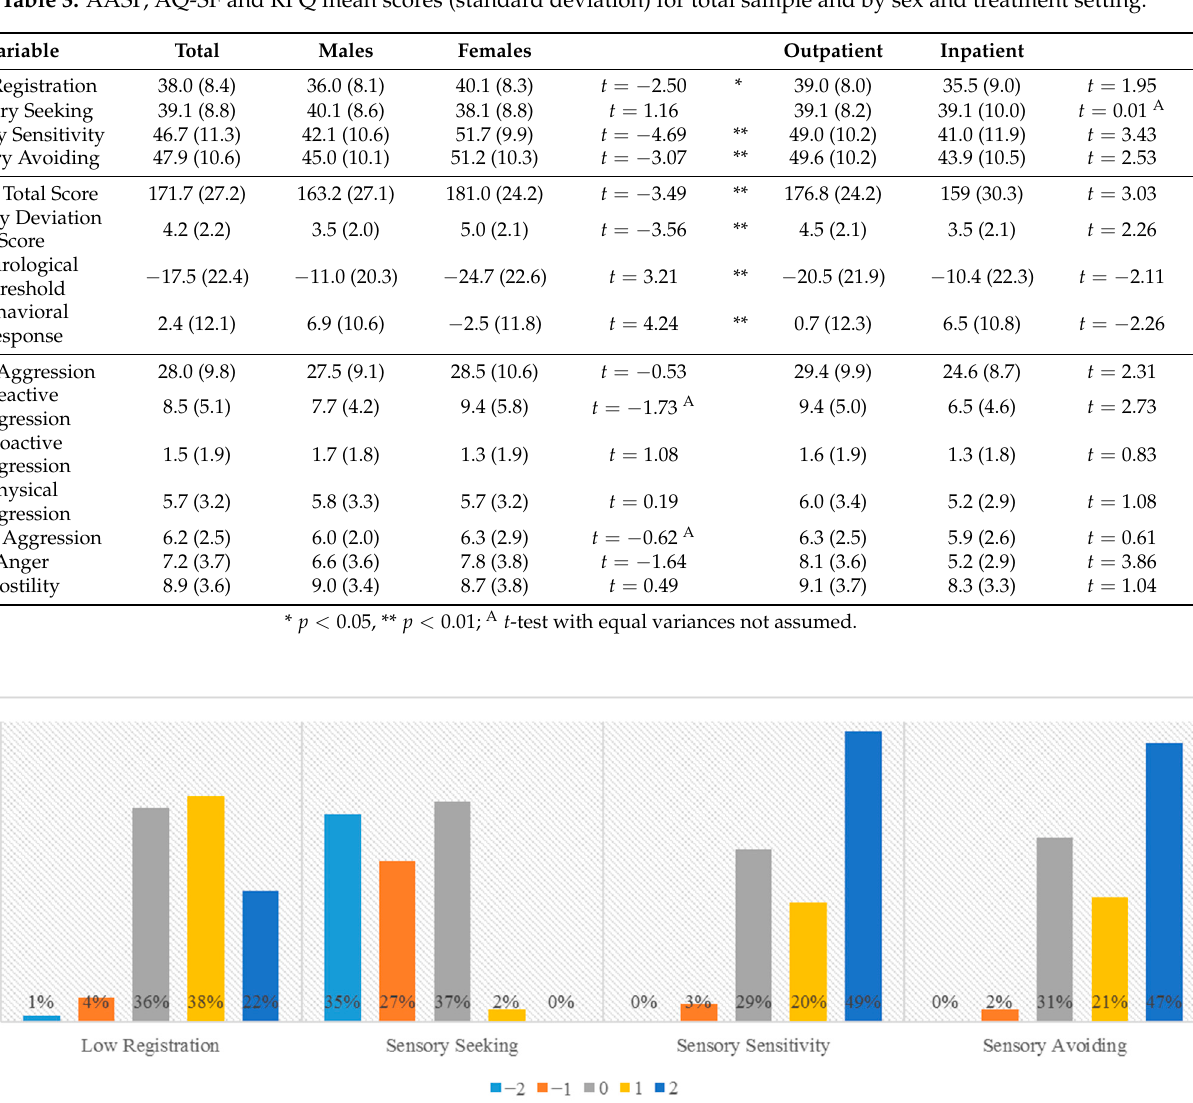
Table 3. AASP, AQ-SF and RPQ mean scores (standard deviation) for total sample and by sex and treatment setting.